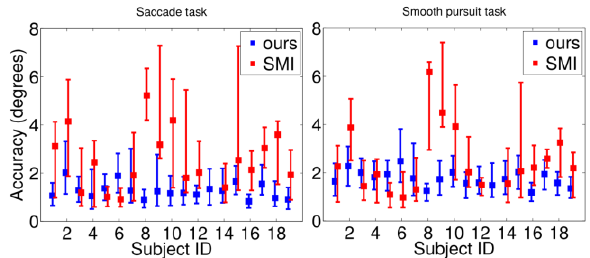
Figure 14. Accuracy values for the saccade task (left panel) and the smooth pursuit task (right panel) for the presented and SMI systems, using all the data. For visu- alization purposes, our results are slightly left and SMI's slightly right of the tick location of the corresponding subject ID. The square depicts the median value and